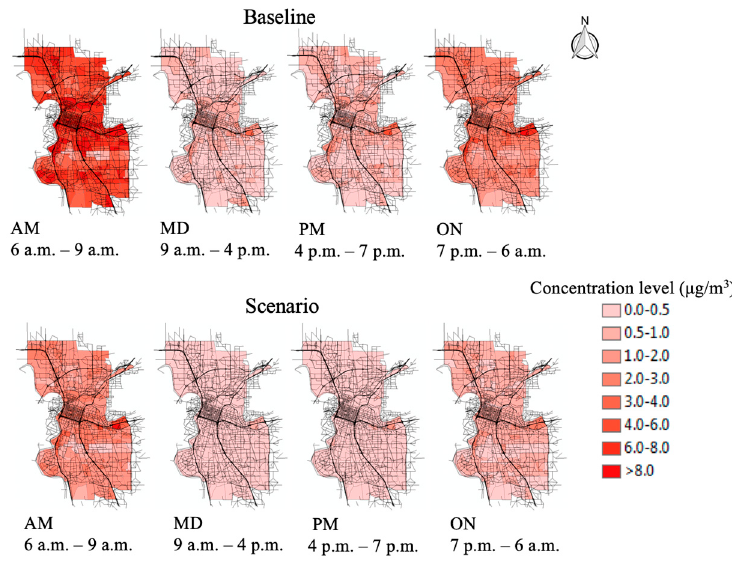
Figure 4. TAZ-level particulate matter (PM 2.5 ) concentrations.